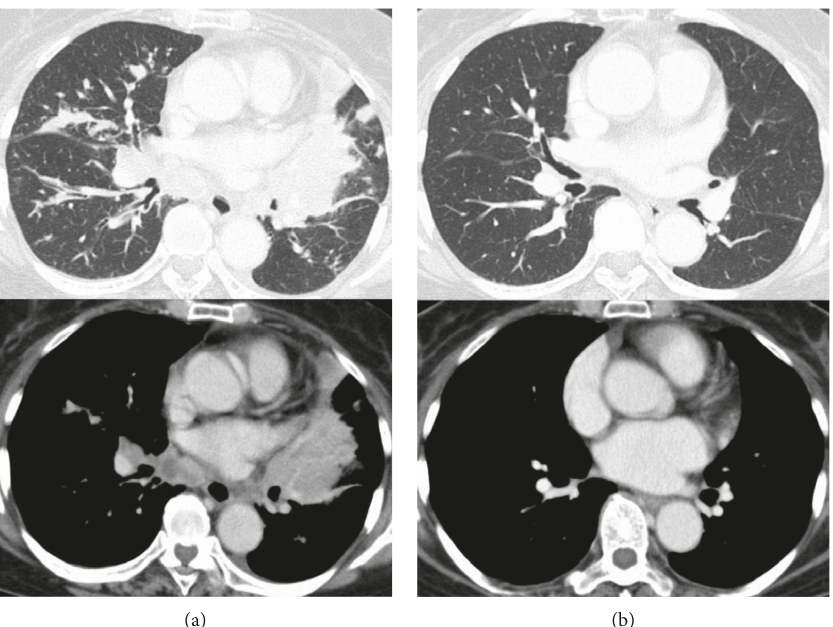
Figure 1: CT findings before and after the treatment. (a) Chest CTat admission. It showed a tumor in the left lower lobe of the lung with mediastinal lymphadenopathy, pleural dissemination, and multiple pulmonary metastases in both of the lungs. (b) CT revealed dramatic tumor reduction in the primary and metastatic lesions, and this had maintained after 9 months since we started the treatment.